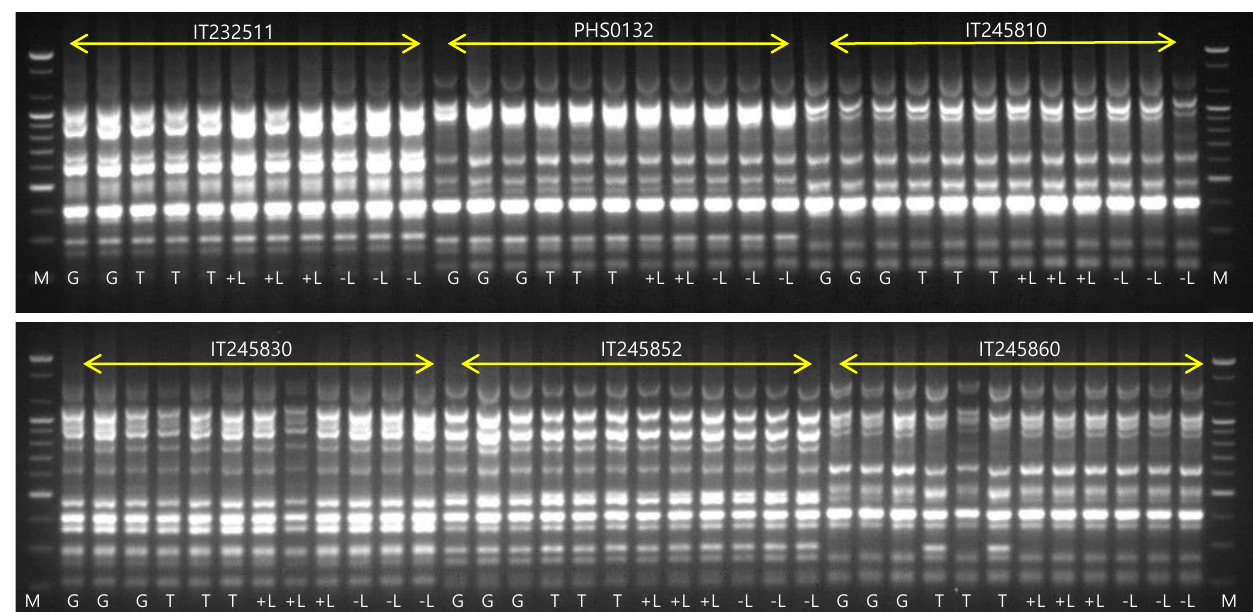
Figure 3. Comparisons of PCR band patterns of ISSR 15 primers obtained from six strawberry accessions from four different treatments (M, 100 bp size marker; G, greenhouse maintained; T, tissue culture; +L, liquid nitrogen exposure; − L, non-liquid nitrogen exposure). Each treatment contained three DNA samples, but two samples were missing due to poor DNA qualities (a GH sample of IT232511 and a +LN sample of PHS0132).